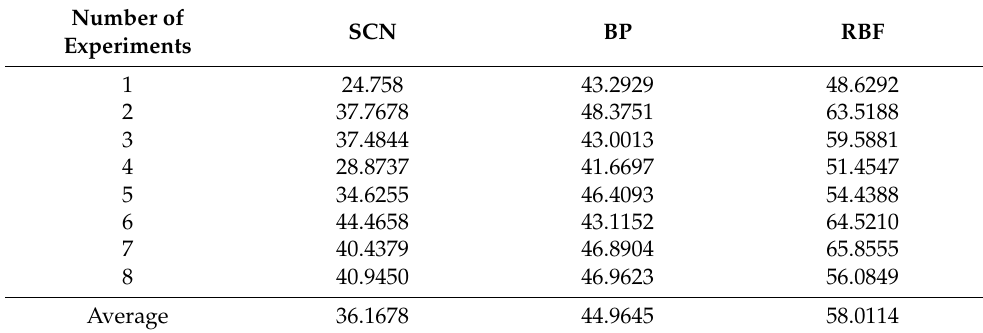
Figure 5. Fitting of incinerator temperature by SCN, BP and RBF. Table 3. Comparison among RMSE (°C) of SCN , BP and RBF.